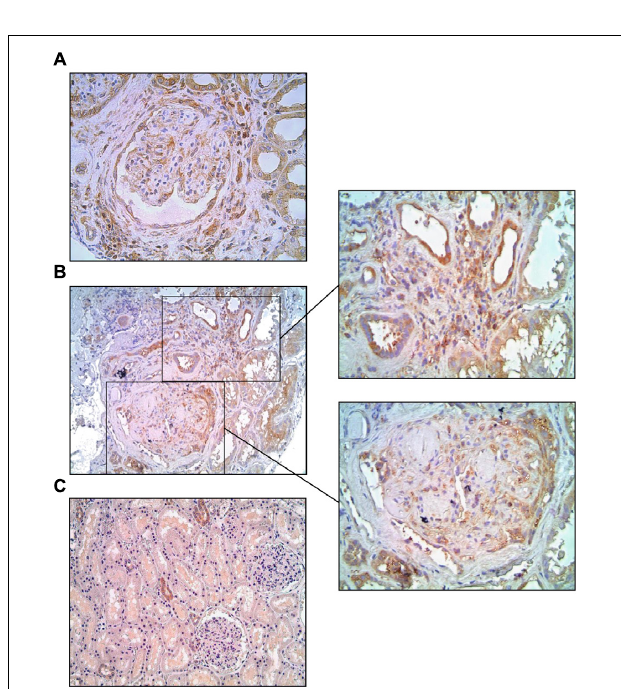
FIGURE 8 | Microphotographs from Type 1 diabetic patients with advanced diabetic kidney disease, immunostained for p65 (brown). The p65 protein was detected in a relatively preserved glomerulus (A) and around Kimmelstiel-Wilson nodules in a more severely affected tuft (B) , as well as in inflamed interstitial areas (A,B) , whereas in normal renal tissue (C) only scattered tubular profiles were stained. Magnification: x200 (B,C) and x400 (A and